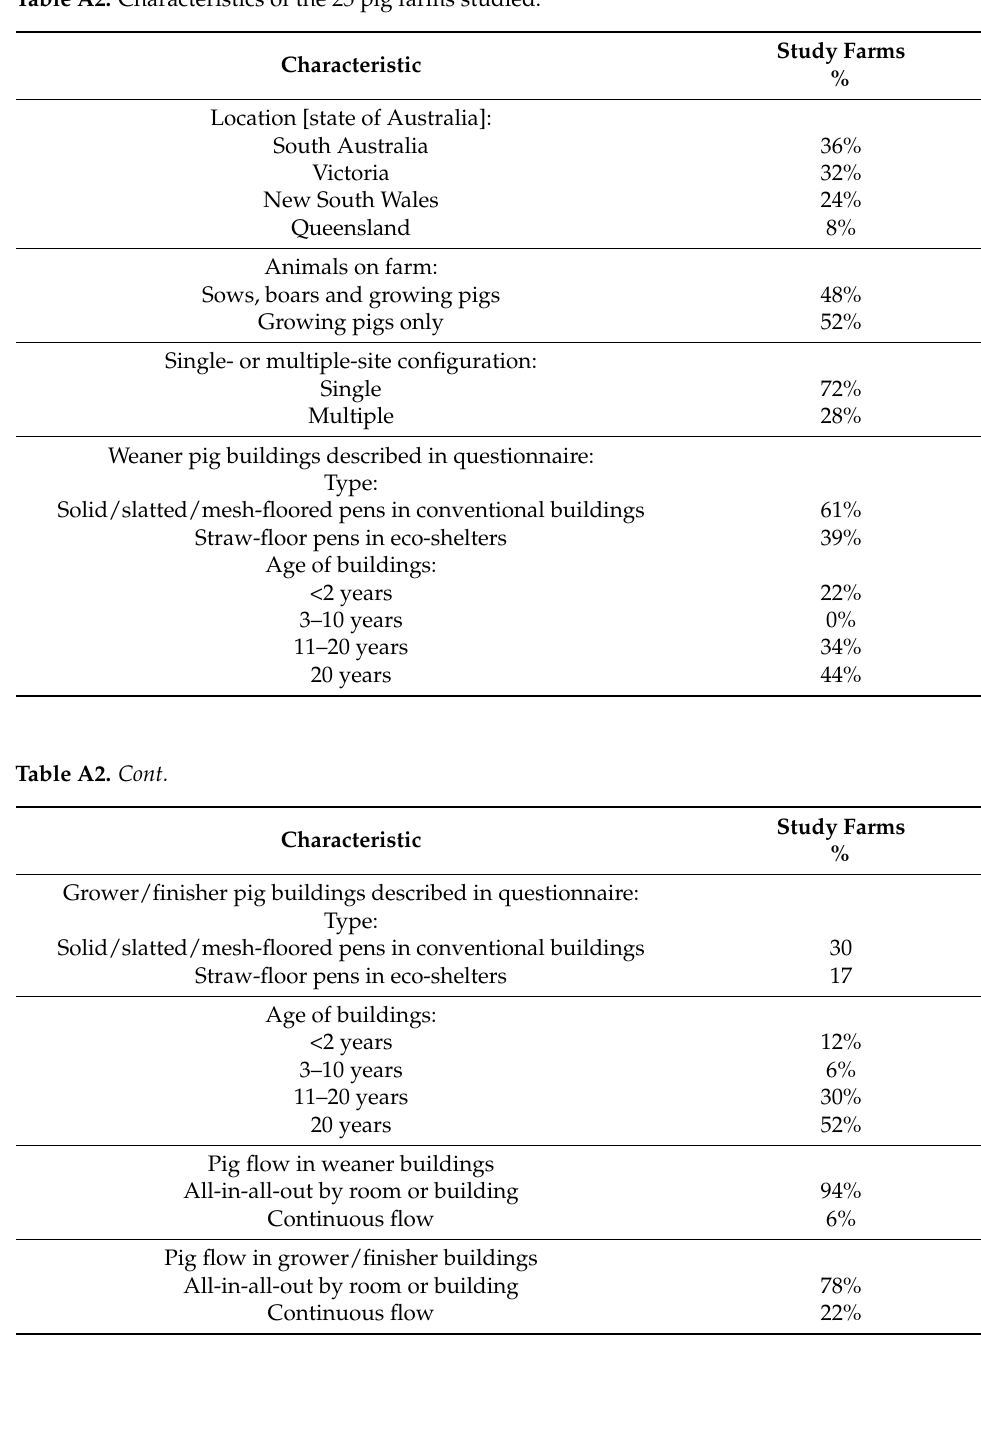
Table A2. Characteristics of the 25 pig farms studied.